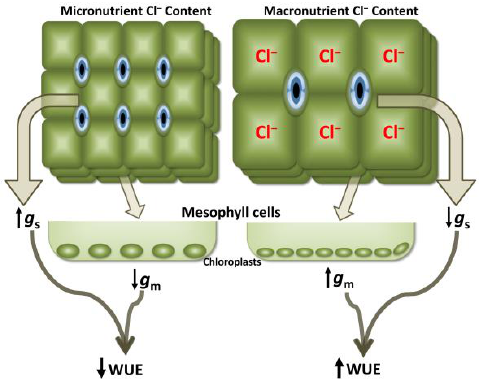
Figure 4. Chloride (Cl − ) nutrition at macronutrient levels significantly increases the size of leaf cells, resulting in a reduction in stomatal density and, therefore, conductance (g s ). At the same time, Cl − improves mesophyll diffusion conductance to CO 2 ( g m ), due, at least in part, to increased surface area of chloroplasts exposed to the intercellular airspace. The higher mesophyll diffusion conductance compensates for the reduction in stomatal conductance, resulting in overall higher WUE [23]. Upward arrows indicate higher values, and downwards indicate lower values. Figure obtained from Maron, 2019